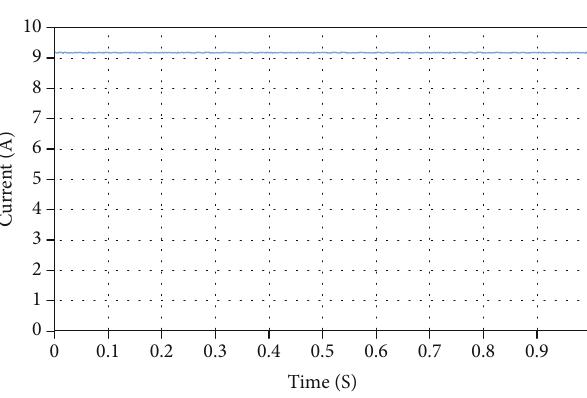
Figure 40: The output power of PV2.